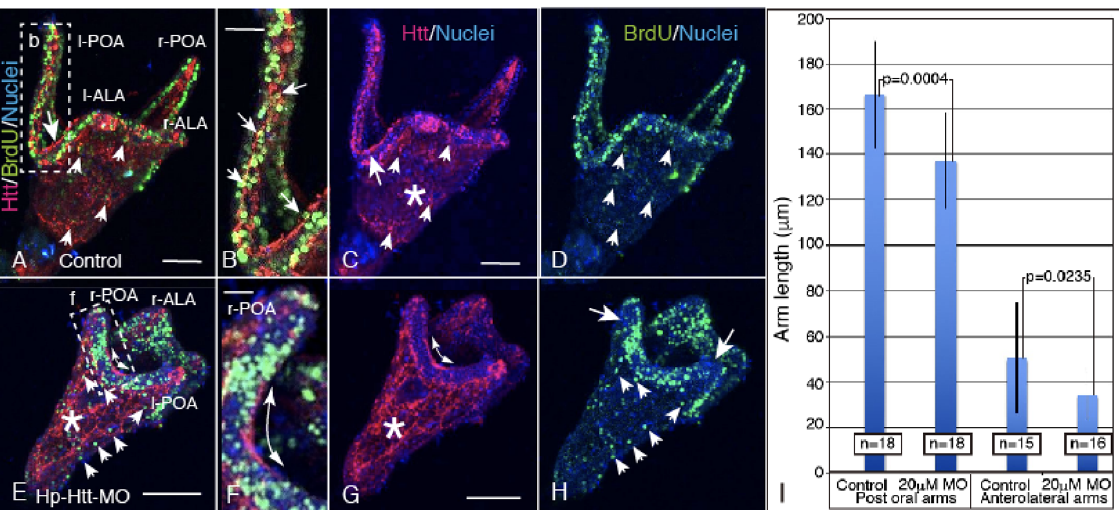
Figure 5. Hp-Htt (red)/BrdU (green)/nuclei (blue) triple stained image of 4aPL. Shortened larval arms due to FL-Htt-MO application occurred, accompanied by decreased BrdU-positive signals, particularly at the larval arm regions. ( A ) Dorsal view of the larva. Hp-Htt (red) was detected at the CBAS (large arrow) and some of the blastocoelar cells (small arrows). ( B ) The highly magnified CBAS area shown by a rectangle (b) in ( A ). BrdU (green) was detected also there (arrows). ( C ) Hp- Htt/DAPI double stained image of ( A ). Arrow; CBAS. Hp-Htt-positive blastocoelar cell network (asterisk). ( D ) At the ectoderm, a smaller number of BrdU-positive signals were detected in the blas- tocoelar cells (arrows) (E ) Ventral view of the FL-Htt-MO treated larva. The number of BrdU-posi- tive signals clearly decreased in the ectoderm, particularly at the tip of arms and in the fragmented CBAS (double-head arrow). ( F ) The highly magnified area shown by a rectangle (f) in ( E ). Shorter arm length is clear at the postoral arms (POA). ( G ) Fragmented CBAS (double-head arrow in ( F ) and ( G )). The blastocoelar Hp-Htt-positive cell network (asterisk) is rather unaffected. ( H ) BrdU- positive signal image extracted from ( E ) clearly detecting the declined positive signal at the tip re- gions of the arms (arrows), while those in the blastocoel were not apparently decreased (small ar- rows). ( I ) Statistical analysis of average arm length comparison between control larvae and FL-Htt- MO -applied larvae with p -value. The larval number examined are shown in a box on each column. Scale bars = 50 µ m ( A , C , E , G ). 25 µ m ( B , F ).